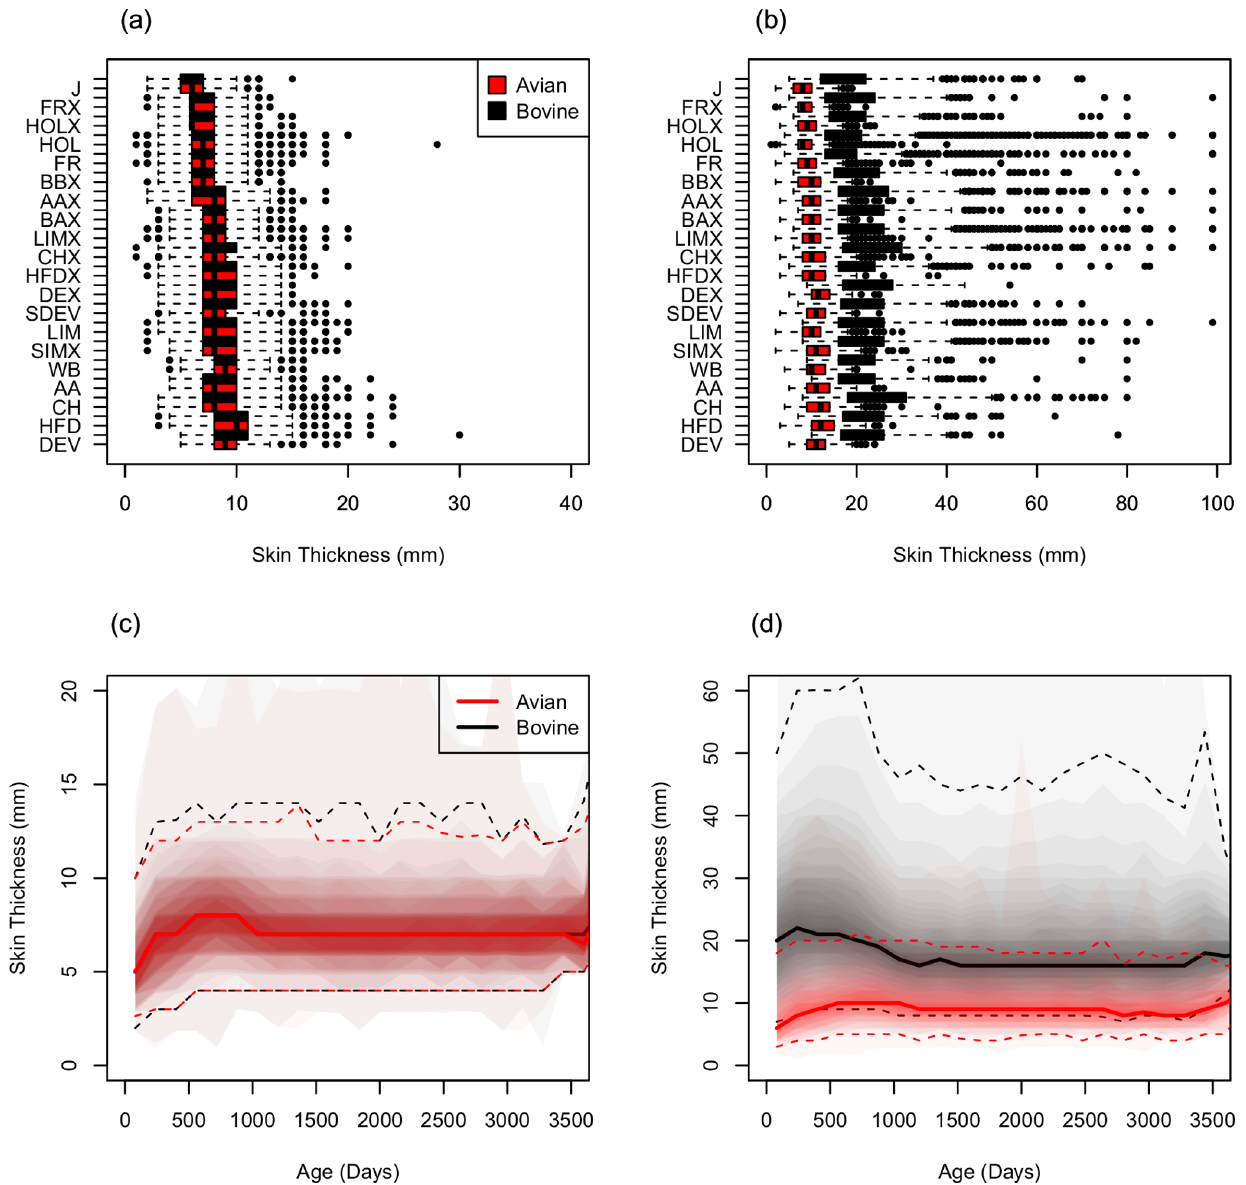
Figure 1. Recorded skin size measurements for reactor animals in VeBus. ( a ) Distribution of first avian (a1) and bovine (b1) measurements stratified by breed for all reactor animals recorded with VeBus and ordered by increasing median value; ( b ) Distribution of second avian ( a2 ) and bovine ( b2 ) measurements stratified by breed for all reactor animals recorded with VeBus; ( c ) Age profile of first avian ( a1 ) and bovine ( b1 ) measurements for all reactor animals in VeBus; ( d ) Age profile of second avian ( a2 ) and bovine ( b2 ) measurements for all reactor animals in VeBus. Given the variability in recorded measurements summary measures are potentially misleading. To demonstrate this variability we plot age profiles as a shaded density strip where the intensity of shading is proportional to the probability of a value at that point [44]. Median (solid lines) and upper and lower 95% ranges (dashed lines) are indicated.